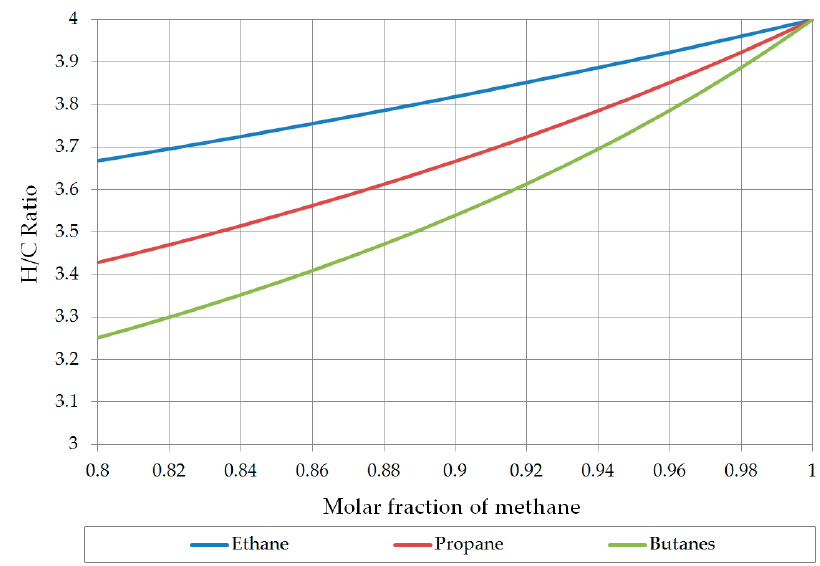
Figure 1. Hydrogen to carbon ratio (for ethane, propane and butanes) vs. methane molar fraction for binary